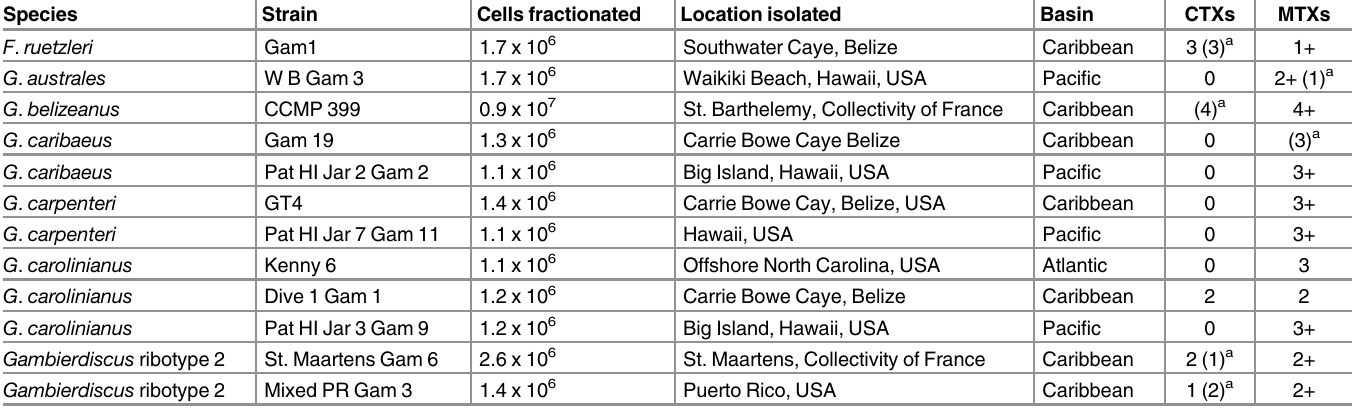
Table 1. Isolates of Fukuyoa and Gambierdiscus spp. from the Pacific and Caribbean and number of CTX- and MTX-like congeners detected using the cell-based assay. The + indicates broad peak(s) likely contain more than a single MTX congener. Species Strain Cells fractionated Location isolated Basin CTXs